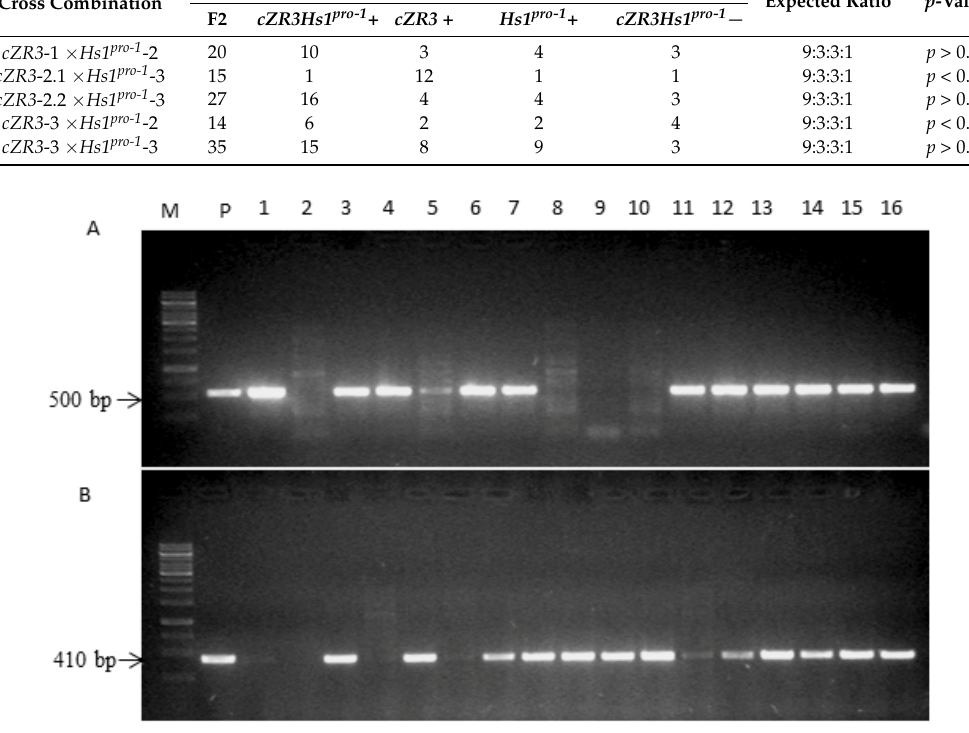
Figure 2. Identification of cZR3Hs1 pro-1 pyramiding homozygous plants in F2 crossing progeny by PCR assay using specific cZR3 and Hs1 pro-1 gene primers. The amplification fragment length of Hs1 pro-1 and cZR3 gene was 500 bp and 410 bp, respectively. ( A ) Identification of Hs1 pro-1 gene in F2 crossing progeny. ( B ) Identification of cZR3 gene in F2 crossing progeny. M represents a molecular marker (1